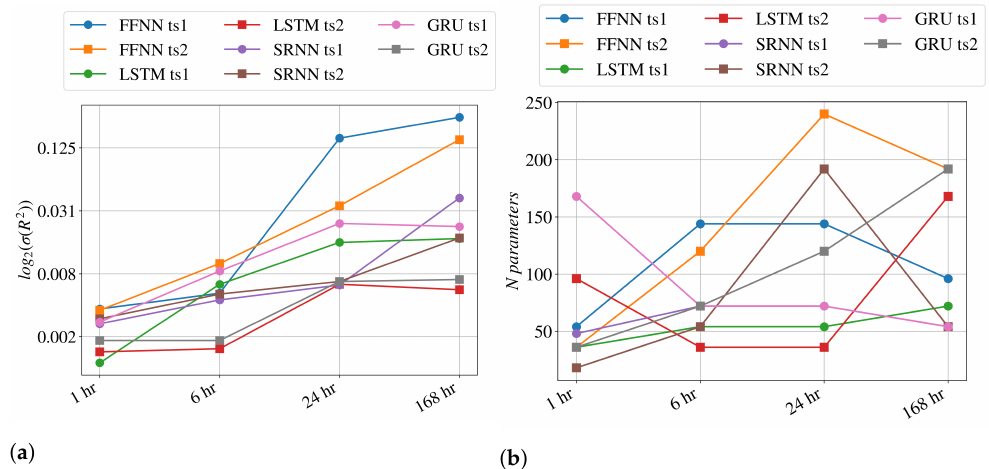
Figure 8. Models’ performance variability within ANN architectures in log 2 ( σ ( R 2 )) of ts 1 (solid lines and circle markers) and ts 2 (solid lines and square markers) for the 4 forecasting horizons (x-axis) with the set of inputs 2 in ( a ). Numbers of nodes of the best models in ( b ).